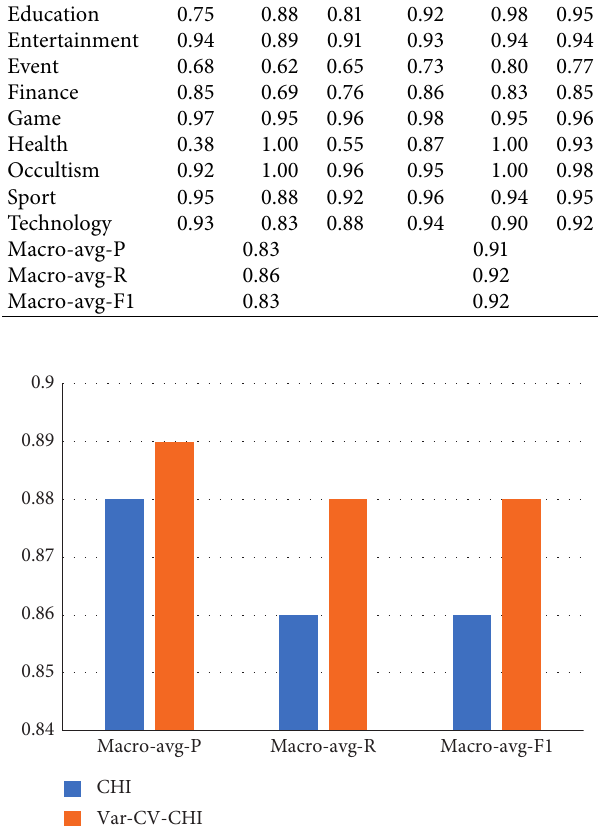
Figure 5: Comparison of macroresults between CHI and Var-CV- CHI on the balanced Chinese corpus (Na¨ıve Bayes).